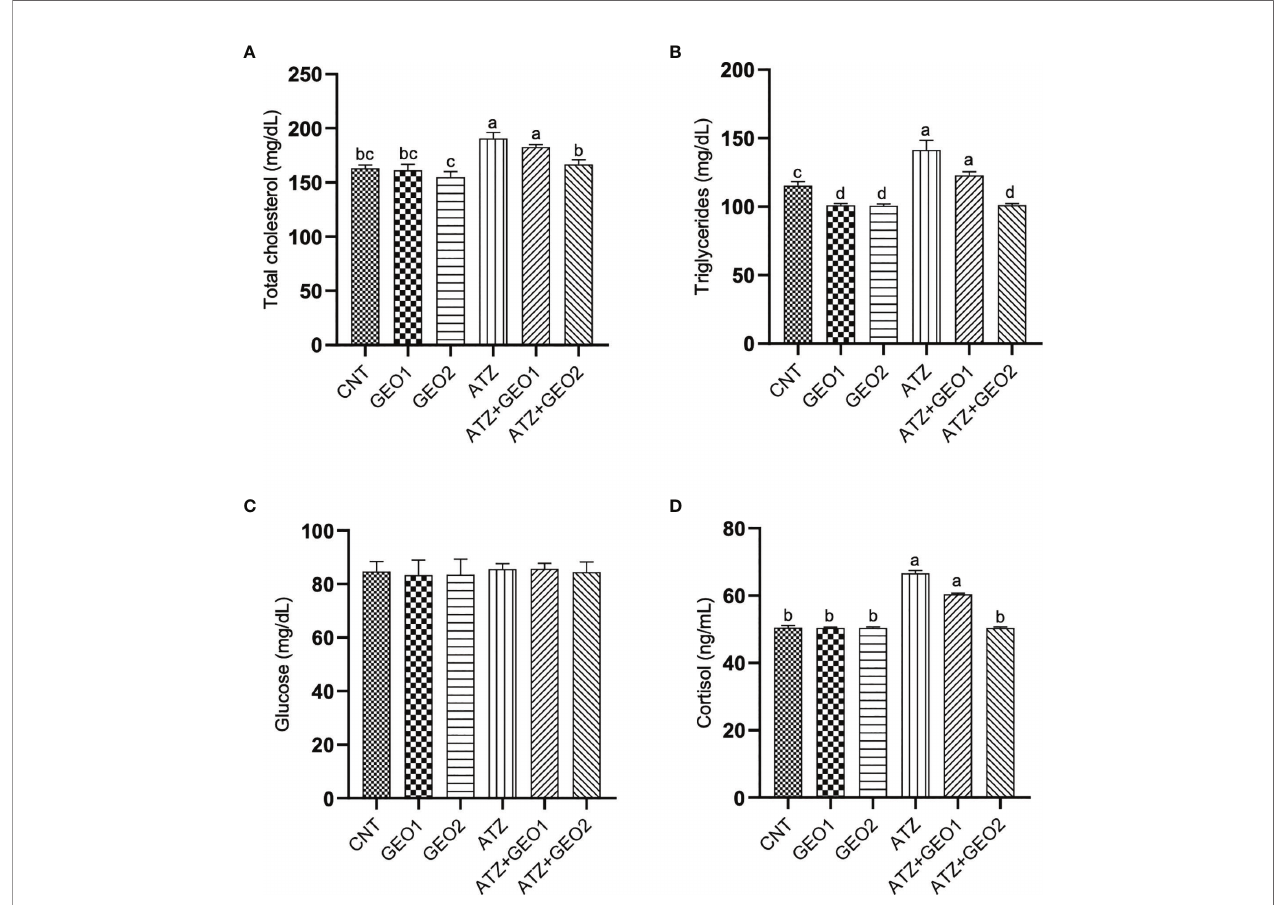
FIGURE 2 | Serum biochemical parameters [total cholesterol (A) , triglycerides (B) , glucose (C) and cortisol (D) ] of Nile tilapia in response to sub-lethal ATZ exposure and/or dietary supplementation with GEO for 60 days. Values are expressed as means ± S.E.M (n = 9). Values that are not sharing a common letter differ signi fi cantly at P <